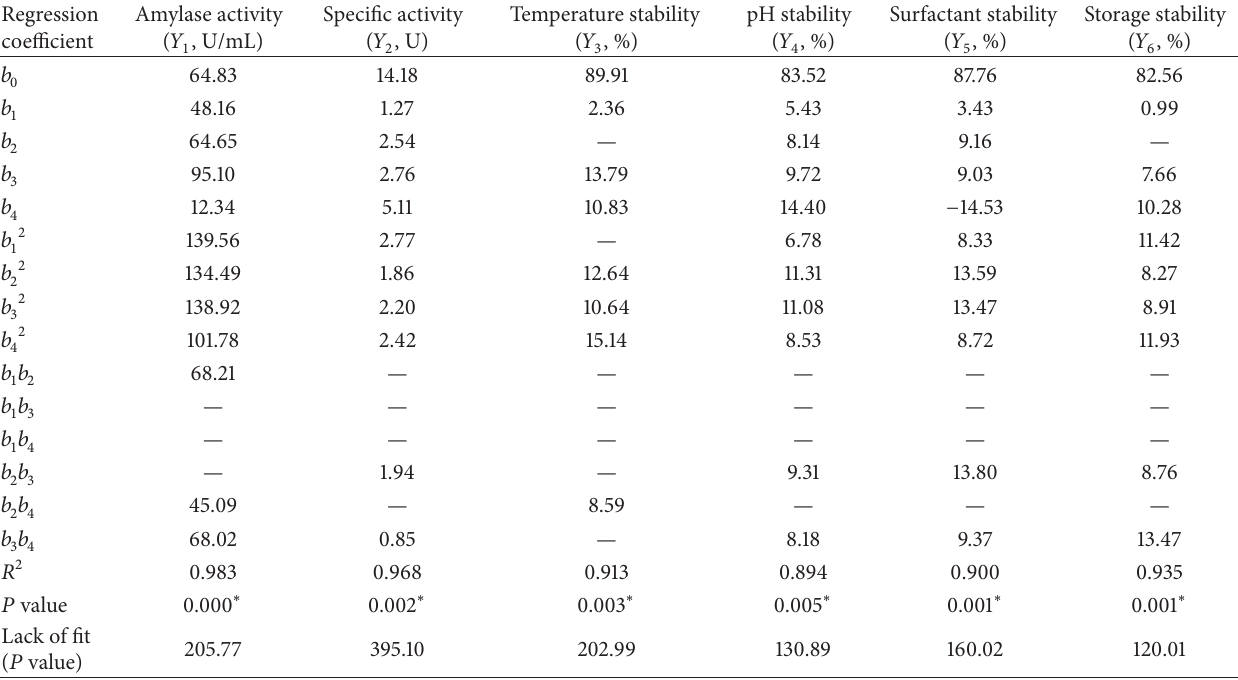
Table 1: Regression coefficients, 𝑅 2 , and 𝑃 value of lack of fit for the final reduced models.